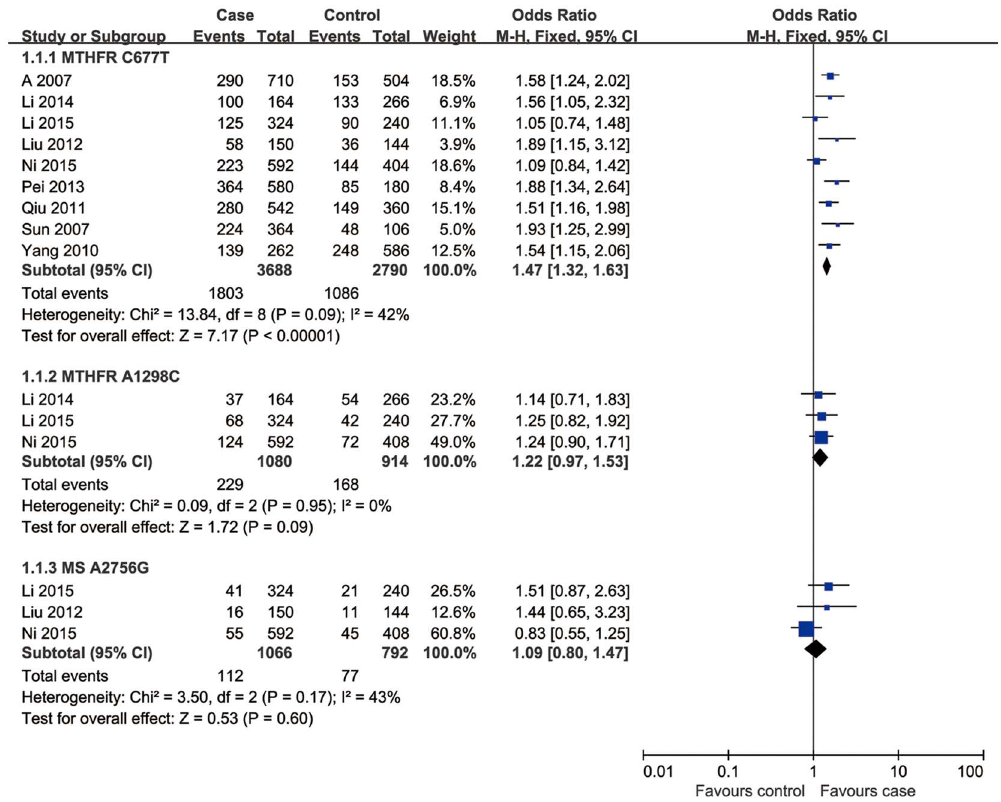
Fig 2. Forest plot of the studies assessing the association between MTHFR C677T, MTHFR A1298Cand MS A2756Gpolymorphisms and male infertility. (allelicmodel: (a) T vs. C, (b) C vs. A, (c) G vs. A).